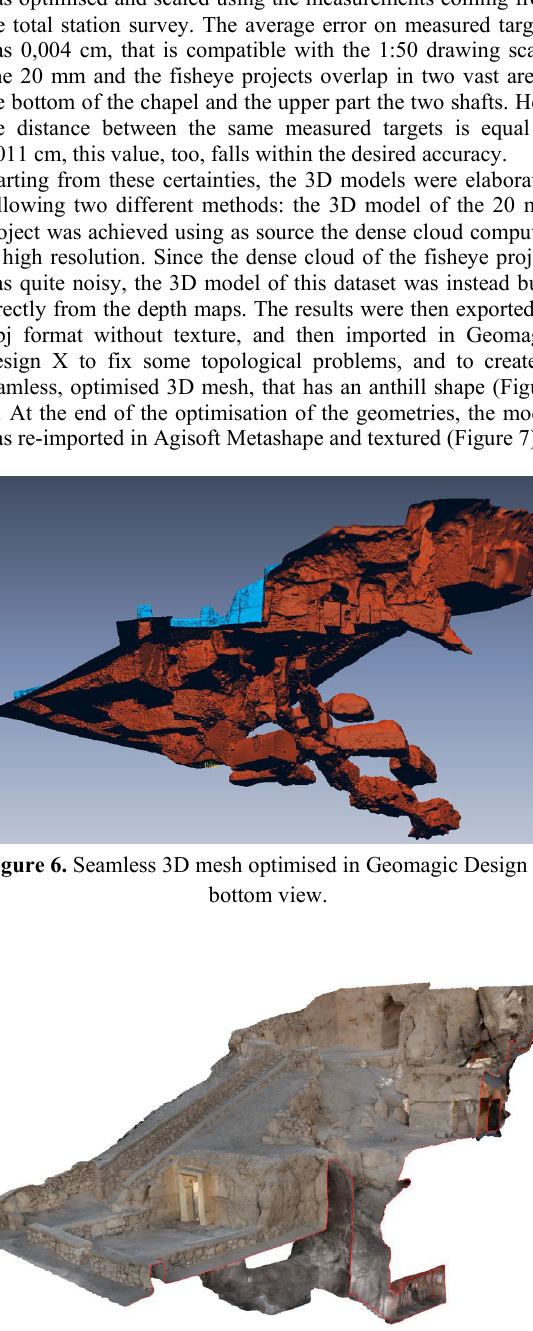
Figure 7 . 3D model sectioned on the funerary chamber, top view.